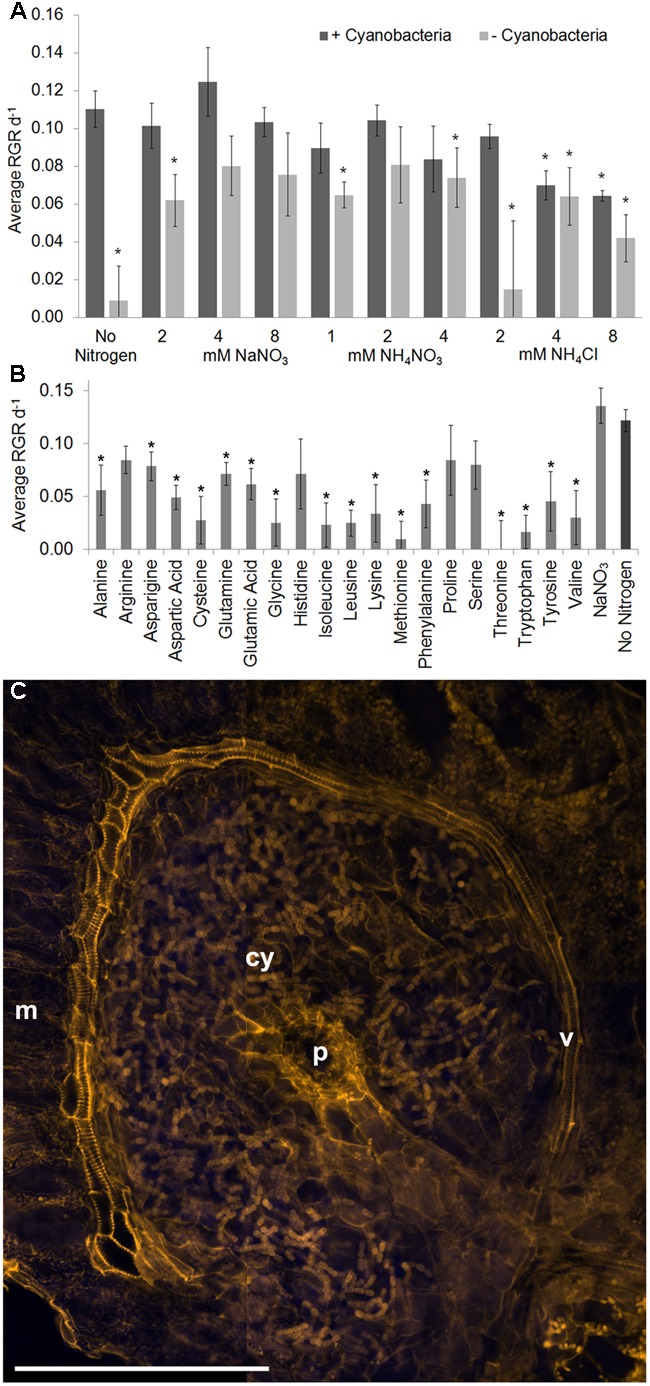
Role of N. azollae in sustaining fern growth and specific structures of the leaf pocket. Clonal ferns with (+cyano) and without N. azollae (-cyano) were grown on agar solidified Standard Azolla Medium (SAM). (A) Growth in inorganic N-fertilizer ranging from 2 to 8 mM. (B) Growth with 2 mM nitrogen in differing amino acids, or with 4 mM NaNO3 (NO3), and +cyano on SAM for comparison. Growth was measured as leaf area. Ferns without N. azollae failed to grow on SAM but in all other conditions growth fitted an exponential curve. Standard deviations with n = 3, T-test significance with reference to ferns +cyano on SAM for P < 0.05 is marked with ∗. (C) Structures revealed by propidium iodide staining using confocal microscopy 405 nm excitation, 560 nm emission (orange); auto-fluorescence at 515–530 nm emission (blue). v, vasculature; p, pore; cy, N. azollae bacteria; m, mesophyll cells; scale bar: 200 μm.